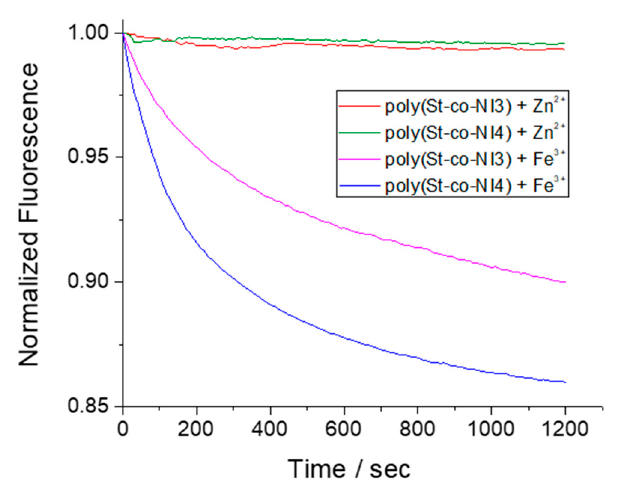
Figure 15. Change in fluorescent intensity of poly (St-co-NI3) (1) and poly (St-co-NI4) in the presence of metal cations (c = 10 − 5 mol L − 1 ).